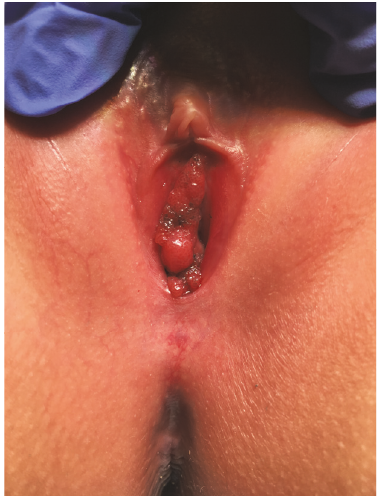
Figure 2: Photograph of the genital area after excision, with visualization of the urethra and vaginal